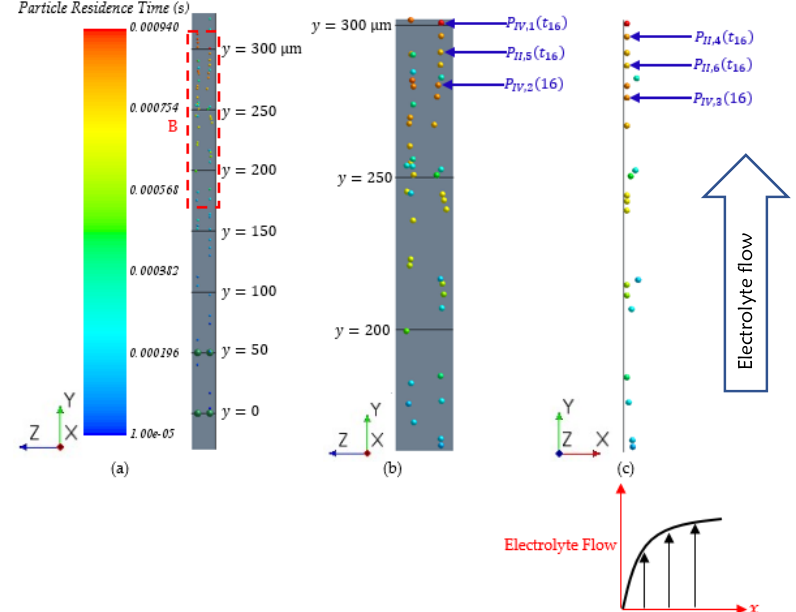
Figure 12 The Star CCM+ simulation results at 𝑡 16 = 940